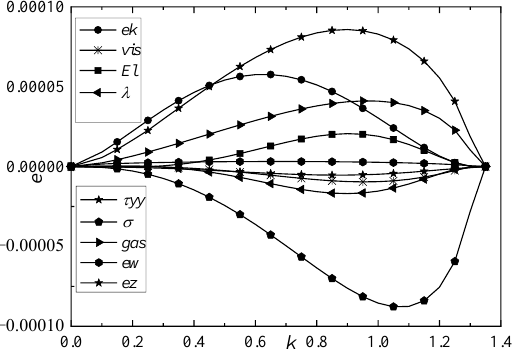
Figure 9. Rates of change in kinetic energy and various forces for sinuous mode.